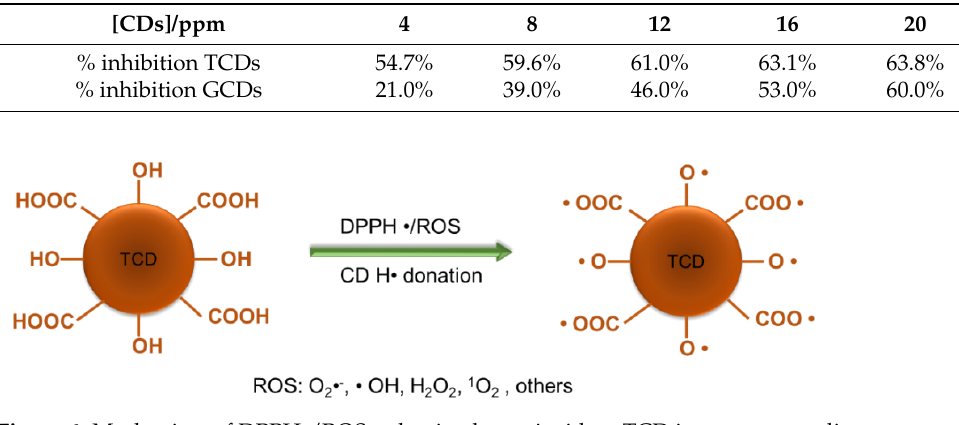
Figure 6. Mechanism of DPPH·/ROS reduction by antioxidant TCD in aqueous media.